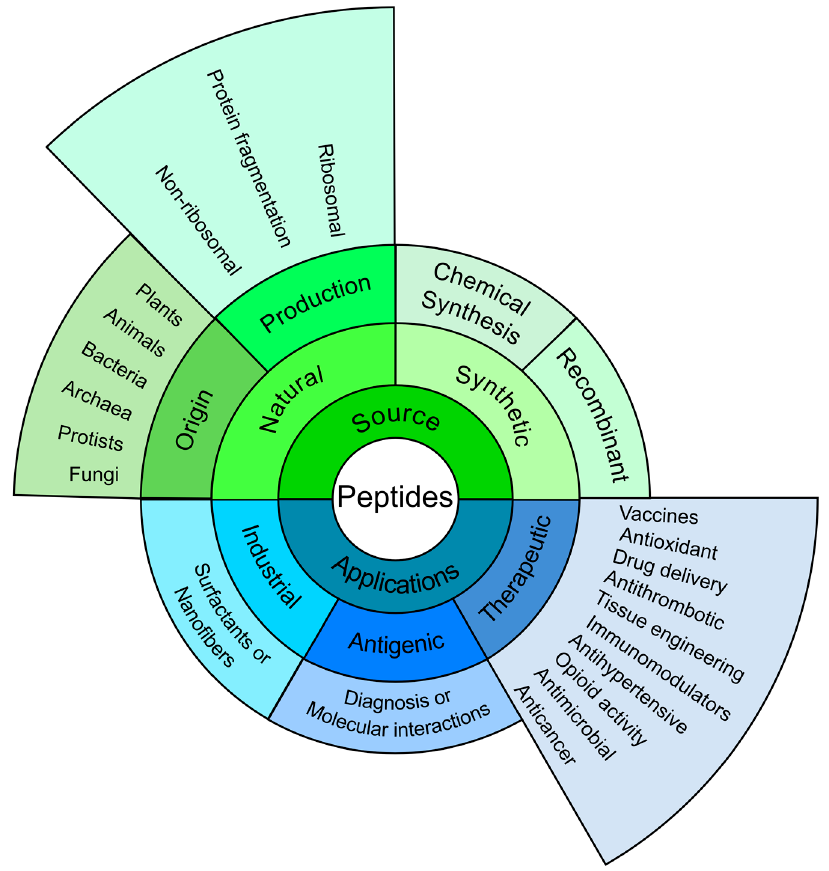
Figure 1. Peptides overview : The figure summarises the main aspects related to peptides: origin, classes and applications. As can be observed, although having some industrial applications [19,20], synthetic peptides are also used as antigens in diagnosing diseases [21,22], studying molecular interactions [23], and identifying pathogens proteins’ functional regions [24–26]. However; it is worth highlighting their scope in the vast field of therapeutic applications [27–34].